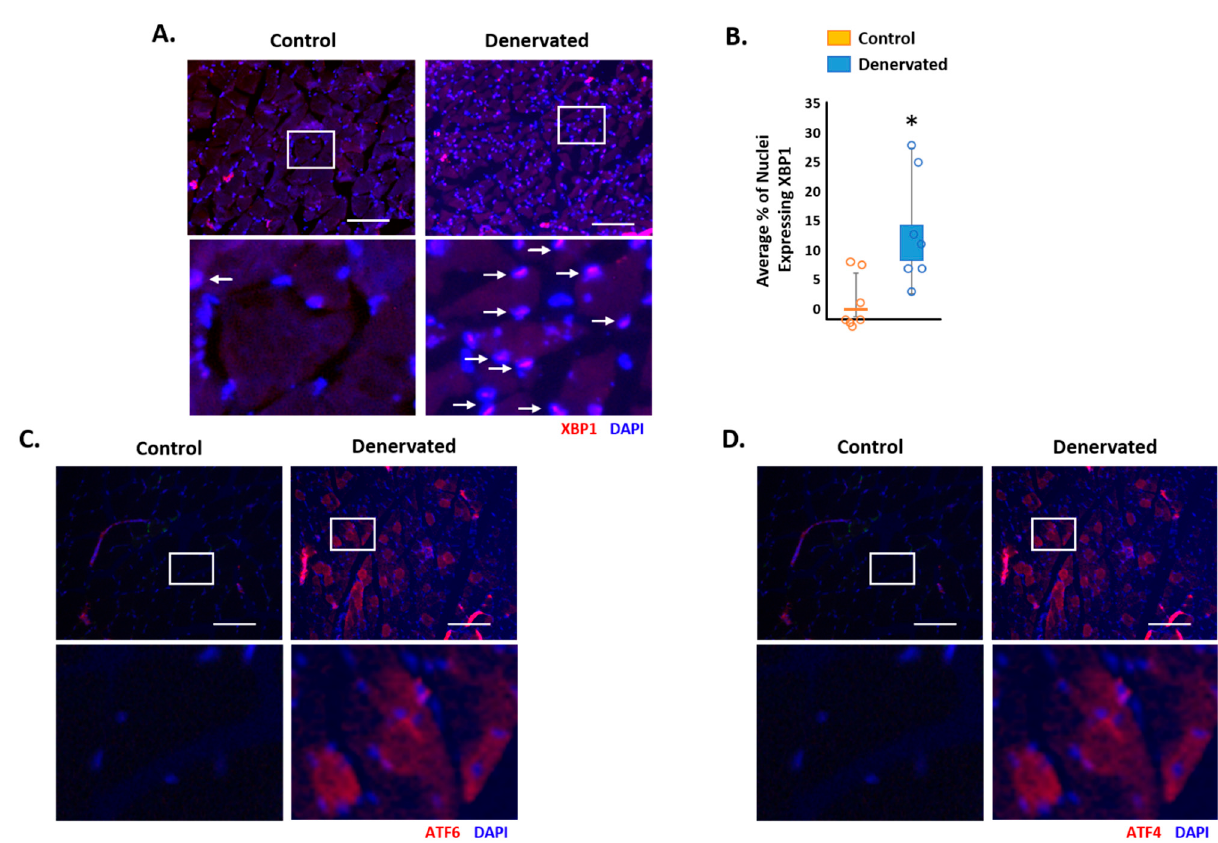
Figure 3. Effect of transection of the sciatic nerve on expression of the unfolded protein response (UPR) in skeletal muscle. ( A ) Representative images of the control and denervated TA muscles immunostained against XBP1 and DAPI. Scale bar = 100 μ m. ( B ) Average percentage of nuclei expressing XBP1 in the control and denervated TA muscles. ( C ) Representative images of the control and denervated TA muscles immunostained against ATF6 and DAPI. ( D ) Representative images of the control and denervated TA muscles immunostained against ATF4 and DAPI. * p < 0.05, values significantly different from the control mice by a paired two-tailed t -test.